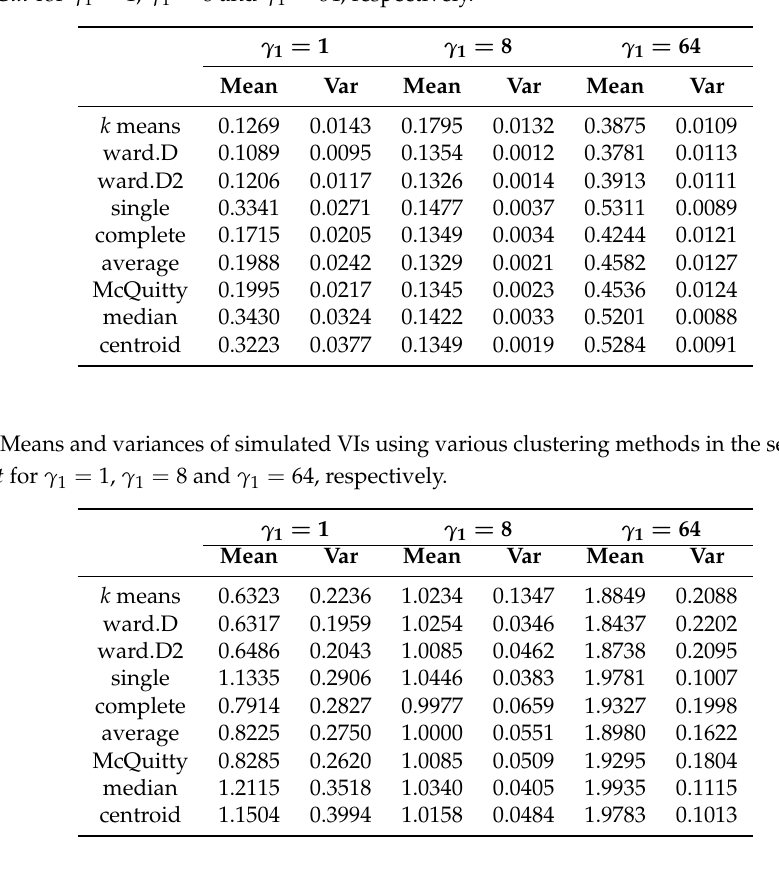
Table 1. Means and variances of simulated MEs using various clustering methods in the second stage of WNACut for γ 1 = 1, γ 1 = 8 and γ 1 = 64, respectively.